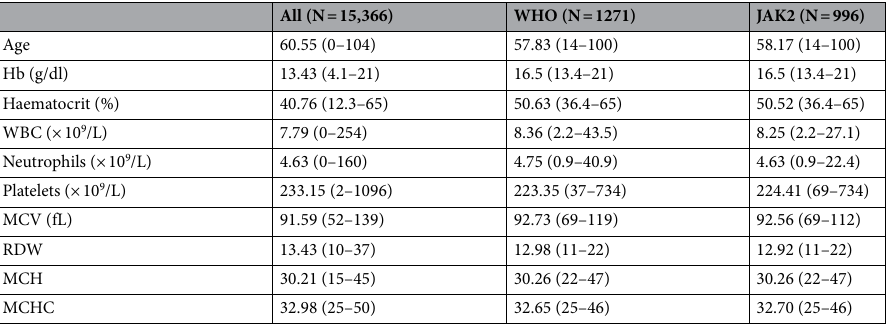
Table 1. Characteristics of study groups. WHO individuals meeting World Health Organization 2016 Hb or Htc criterion, JAK2 patients in which JAK2 p.V617F was studied, Hb haemoglobin, WBC white blood cells, MCV mean corpuscular volume, RDW red cell distribution width, MCH mean corpuscular haemoglobin, MCHC mean corpuscular haemoglobin concentration.